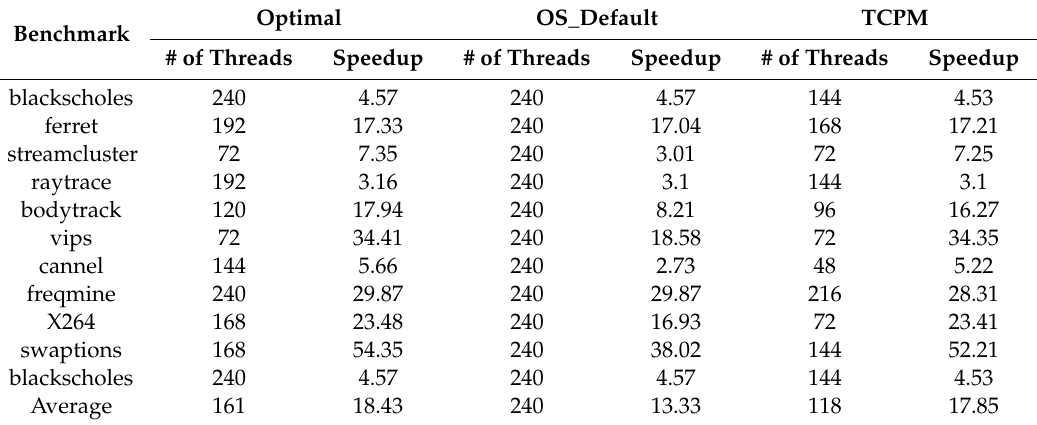
Table 1. Speedup and corresponding thread count of the three strategies.